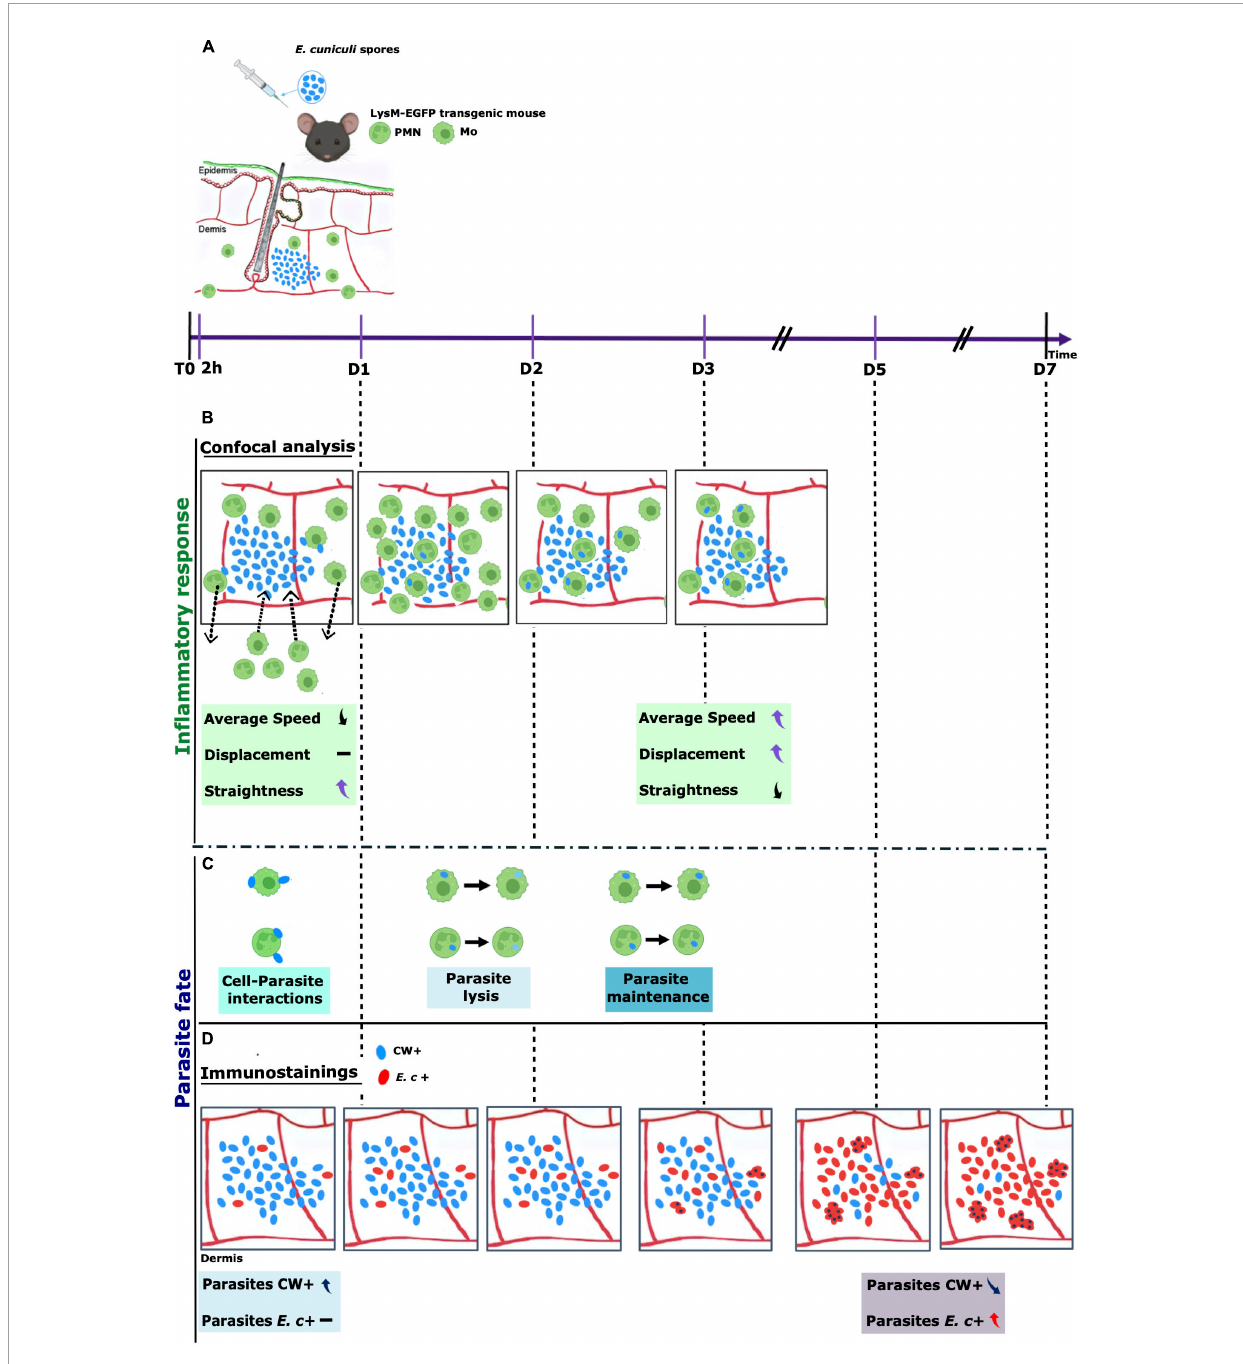
FIGURE7 Timeline of E. cuniculi infection in the mouse ear pinna model. Calcofluor White (CW +, blue) labeled spores of Encephalitozoon cuniculi were inoculated intradermally into the ear pinna of LySM-EGFP mice (EGFP + phagocytes, green). Fluorescent resident Mo, and circulating monocytes and PMN are detected in the mouse ear pinna tissue (A) . The presence of the parasite in the tissue induced a massive (peak at 24 h pi) and persistent inflammatory response over time (until day 7 pi). Phagocytes were recruited to the injection site as early as 2 h pi (incoming arrows). Different cell behaviors were observed. Some cells decreased their speed and sometimes arrested to interact with spores. Other cells left rapidly the injection site after interacting or not with parasites (outcoming arrows). Cell motility parameters of the recruited cells were measured at 2 h pi and 72 h pi: speed average, displacement length and straightness were modified in presence of parasites. At 2 h pi, average speed was decreased whereas straightness was increased. At 72 h pi, average speed and displacement length were increased whereas straightness was decreased (B) . Numerous spores were observed inside EGFP + phagocytes from 24 h to 72 h pi. For some parasites, the CW fluorescent signal decreased during the video acquisition time, in favor of parasite phagocytosis and lysis inside phagocytes. For other parasites, the CW fluorescent signal continued, in favor of parasite maintenance inside phagocytes (C) . Immunolabellings were performed on ear tissue cryosections of infected mice, from 2 h to 7 days pi. CW +: spores, blue; E.c +: other parasite development stages, red. Increasing numbers of E.c + parasites were detected over time, with the presence of high numbers of infectious foci at days 5 and 7 pi in the dermis. These observations were strongly in favor of the ability of E. cuniculi to develop and to proliferate in the mouse ear pinna model showed higher an increase of the E. c + signal and a decrease in the Cw + signal over time. The formation of infectious foci as early as 5 days and which grew over time These observations are in favor of the development of the parasite in the tissue and the partial efficiency of phagocytosis (D)